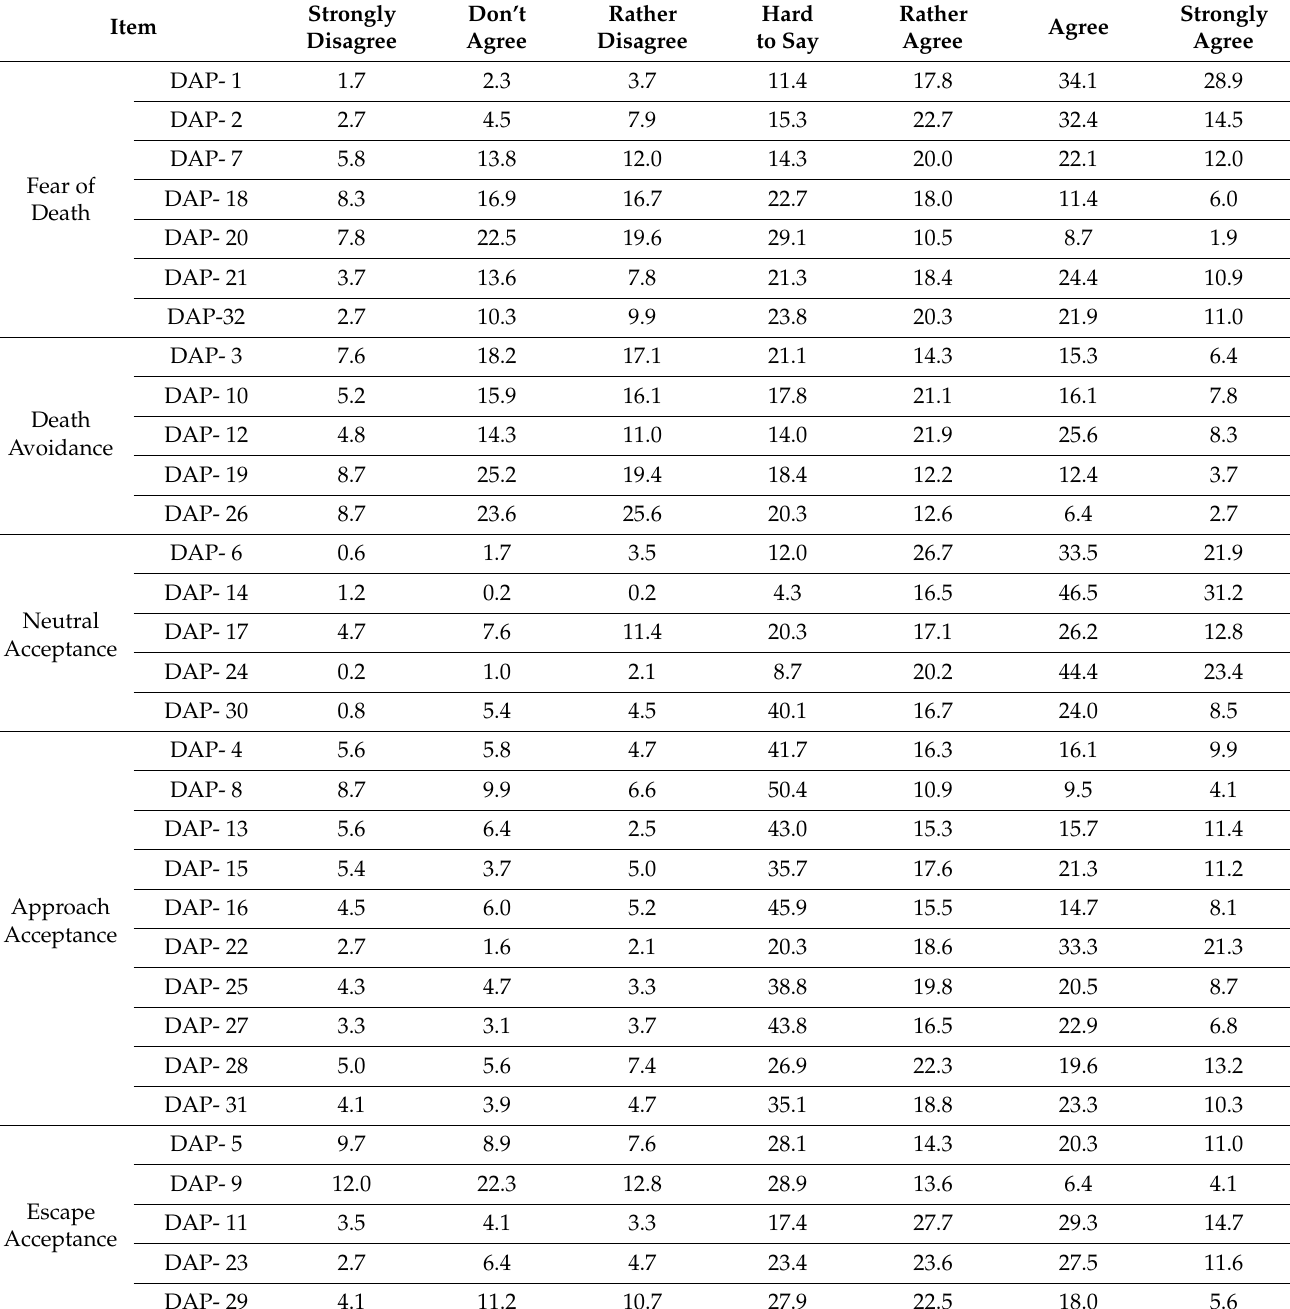
Table 2. Partial results of the DAP-R-PL scale [%] (N =